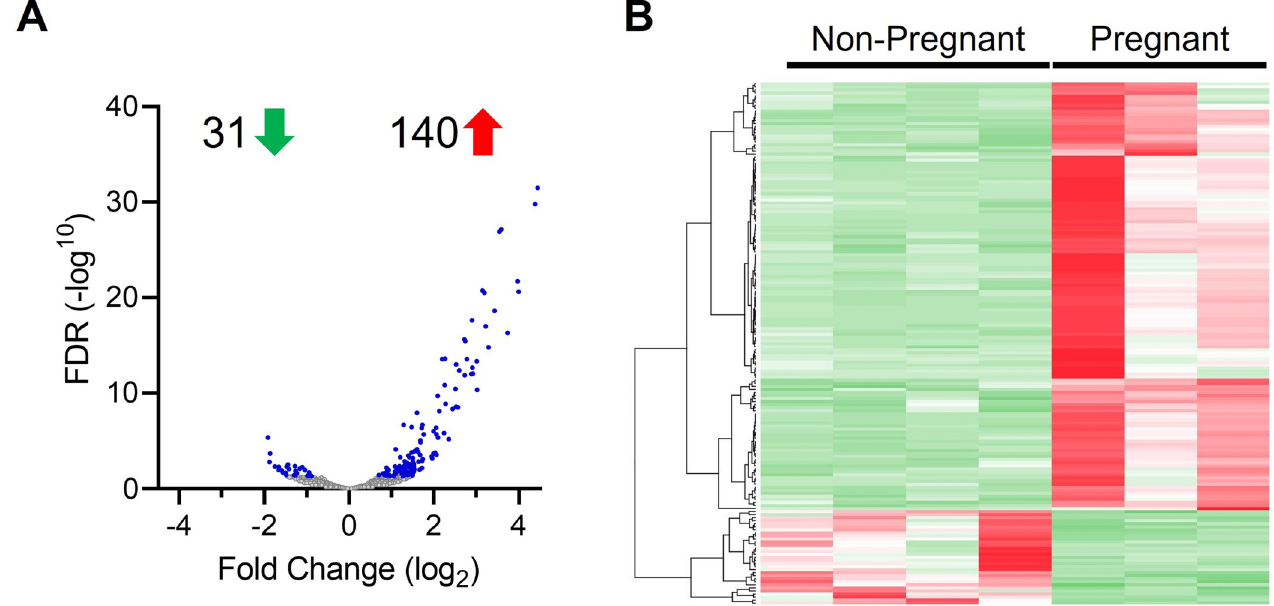
Fig 1. Pregnancy regulated genes following intrauterine infusion of pathogenic bacteria. Cows were inseminated 130 days after intrauterine infusion of pathogenic bacteria and endometrium was collected 16 days later. Based on the presence of an embryo and interferon tau, cows were designated as pregnant (n = 3) or non-pregnant (n = 4). Intercaruncular endometrium was subjected to RNA sequencing analysis. (A) Volcano plot depicting the fold change (log2) and false discovery rate (-log10 FDR) of each endometrial gene of pregnant cows compared to non-pregnant cows. Differentially expressed genes (FDR < 0.05) are colored blue. A total of 140 genes were upregulated and 31 genes were downregulated in the endometrium of pregnant cows compared to non-pregnant cows. (B) Heatmap presents hierarchal clustering of differentially expressed genes with each column representing a single cow and each row a single gene. Rows were clustered with Pearson distance measurement method and complete linkage. Gene expression intensities are shown in green (decreased) to red (increased).